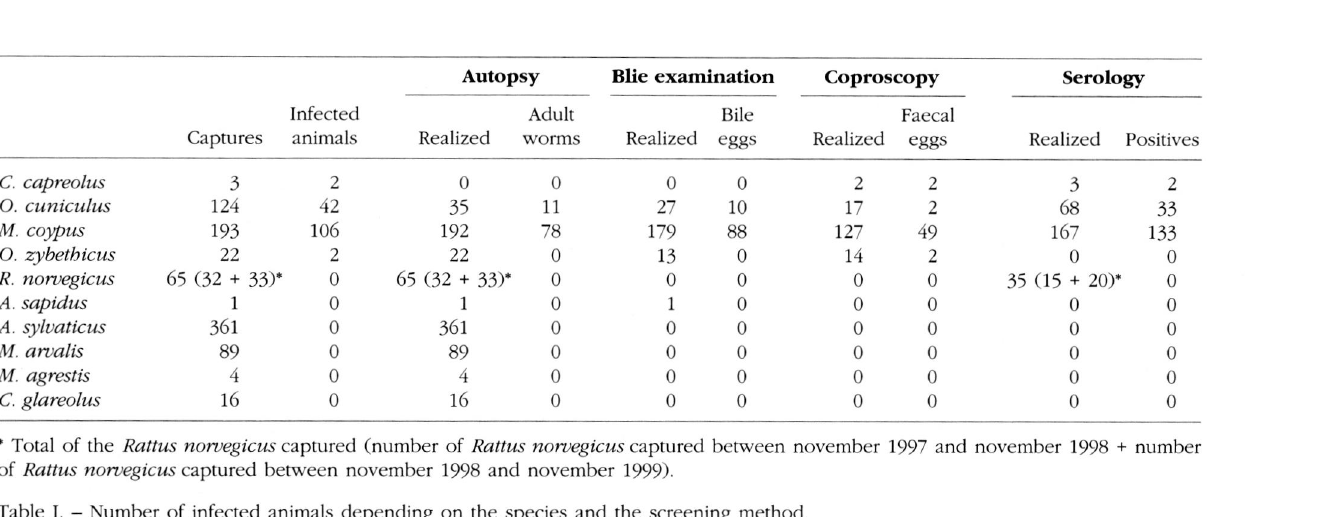
O. cuniculus M. coypus O.